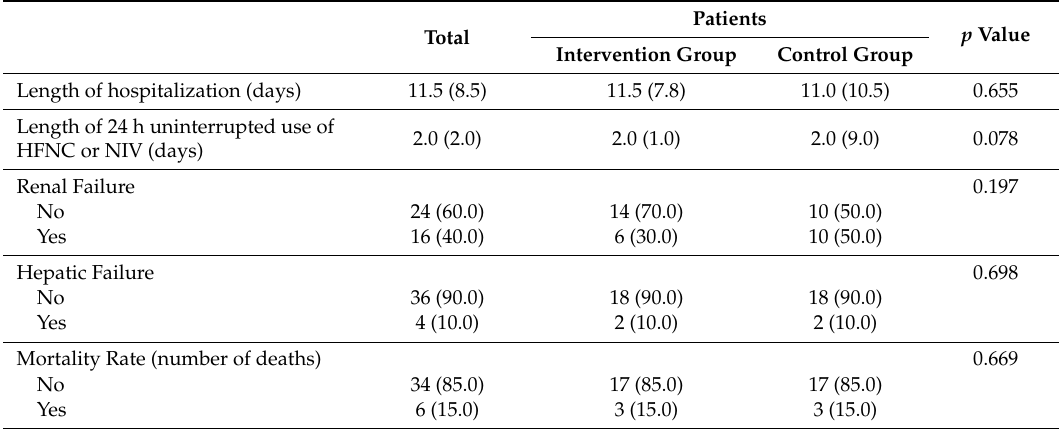
Table 3. Length of hospitalization, complications, and mortality rate.